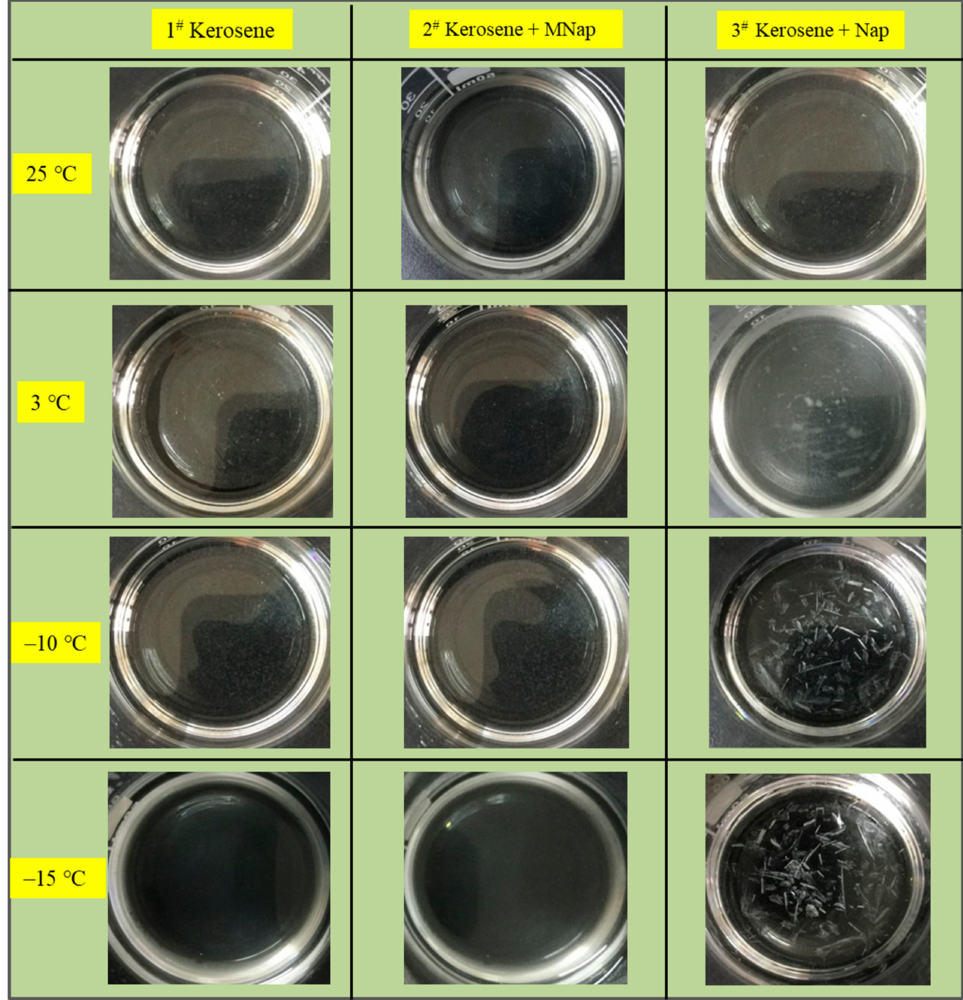
Figure 11. Crystallization characteristics of the three collectors at different temperatures. Therefore, it can be concluded that although “kerosene + Nap” can improve the flotation index of molybdenite, it is not suitable for molybdenite flotation in the northern cold winter area. However, the existing state of MNap at room temperature and low temperature shows no change. As a result, MNap can be used as auxiliary collector and mixed with kerosene to improve molybdenite